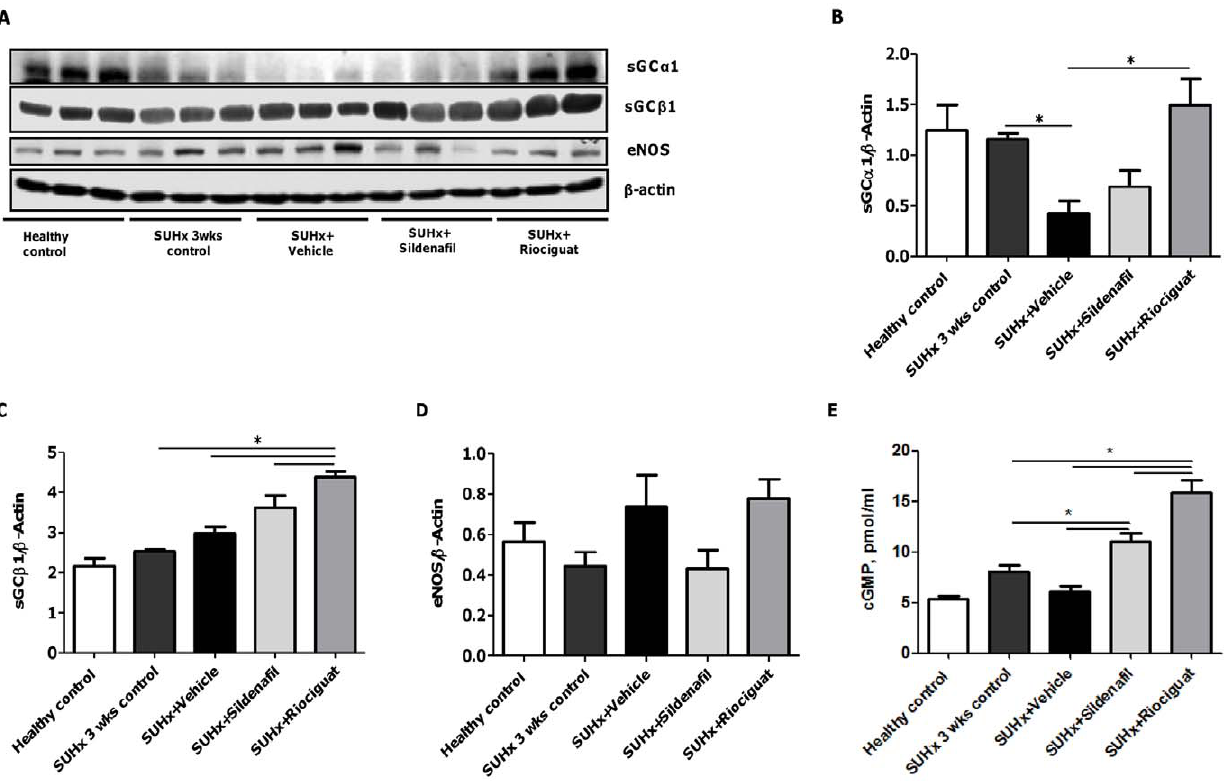
Figure 6. Effects of riociguat and sildenafil on sGC and eNOS protein levels, and cGMP concentration in the lung tissue of SUHx rats. (A) Western blotting of eNOS, sGC a 1 and sGC b 1, (B) densitometric analysis of sGC a 1/ b -actin, (C) densitometric analysis of sGC b 1/ b -actin, (D) densitometric analysis of eNOS/ b -actin and (E) concentration of cGMP, in lung tissue of different treatment groups. * p , 0.05. Note. eNOS, endothelial nitric oxide synthase; PDE-5, phosphodiesterase type 5; sGC a 1, soluble guanylate cyclase a 1; sGC, soluble guanylate cyclase; sGC b 1, soluble guanylate cyclase b 1; cGMP, cyclic guanosine monophosphate.